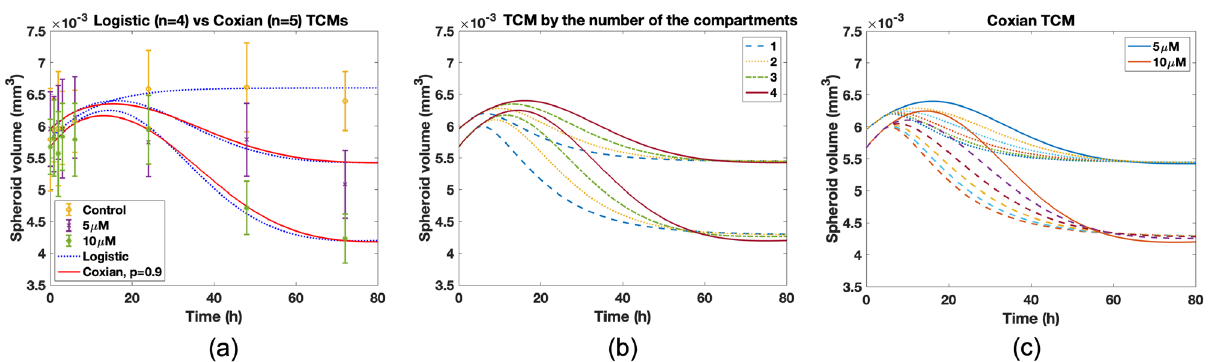
Figure 5. ( a ) Data fit using Erlang and Coxian TCMs with logistic growth. Parameters are estimated for three data set using Erlang TCM with n = 4 . In Coxian TCM with n = 5 , all parameters are the same as Erlang TCM and p = 0.9 . ( b ) In logistic TCM, dynamics are presented by the change of the number of the compartments. Control case is excluded. ( c ) In Coxian TCM with n = 4 , p is variated from 0 to 1 with interval 0.2 and delays are compared to ( b